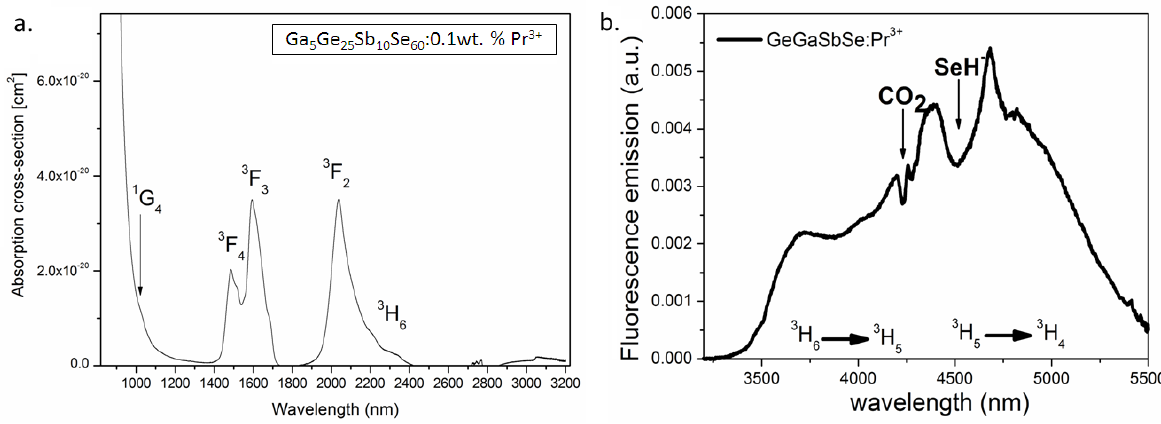
Figure 5. ( a ) Absorption cross-coefficient of Pr 3+ : GaGeSbSe glass; ( b ) Fluorescence emission of Pr 3+ :GaGeSbSe fiber excited at 2 µm. Such fibers, emitting in the mid-IR are very promising in view of detecting chemical species absorbing in the 3.5 to 5.5 µm